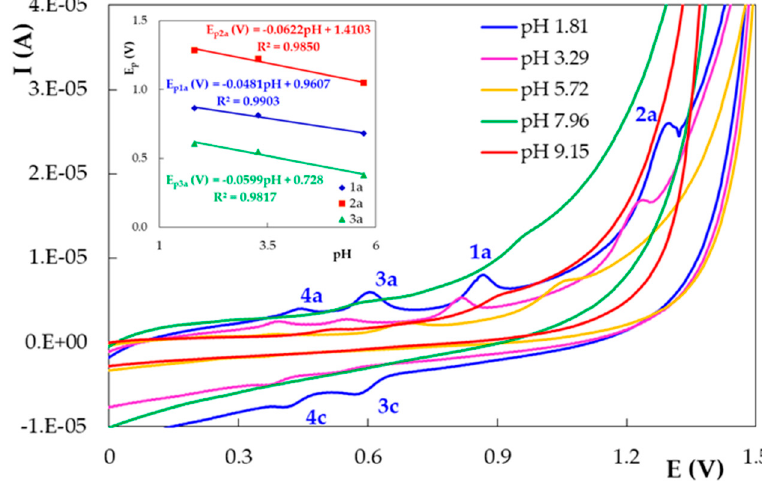
Figure 5. Second scan of the cyclic voltammograms recorded on PGE_H for 1.00 × 10 − 5 mol/L DIO in BRB solution with different pH values; v = 0.100 V/s. The inset shows the peak potential dependencies vs. the solution pH.